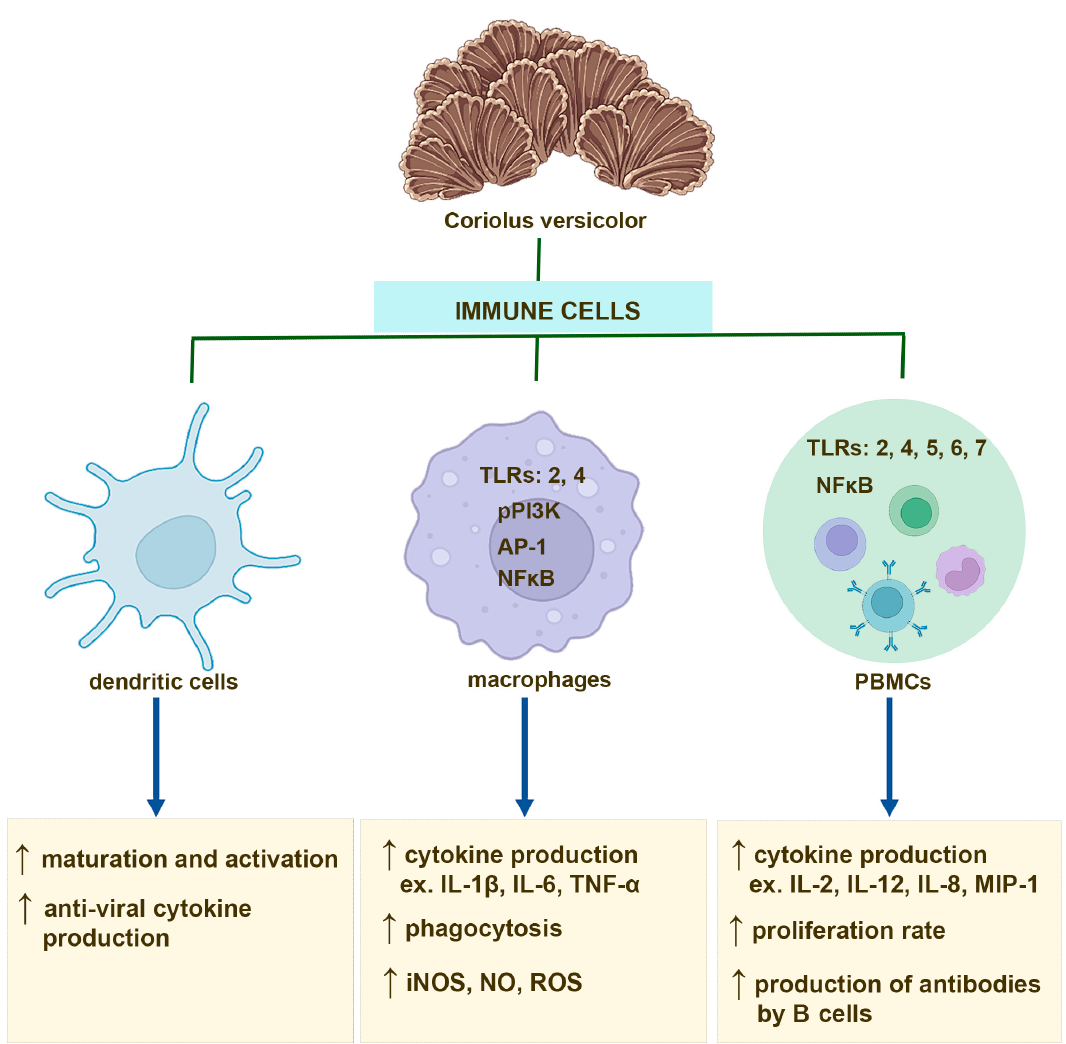
Figure 1. Immunostimulatory effects of the compounds derived from Coriolus versicolor mushroom on dendritic cells, macrophages, and peripheral blood mononuclear cells (PBMCs), including mon- ocytes and B and T cells.